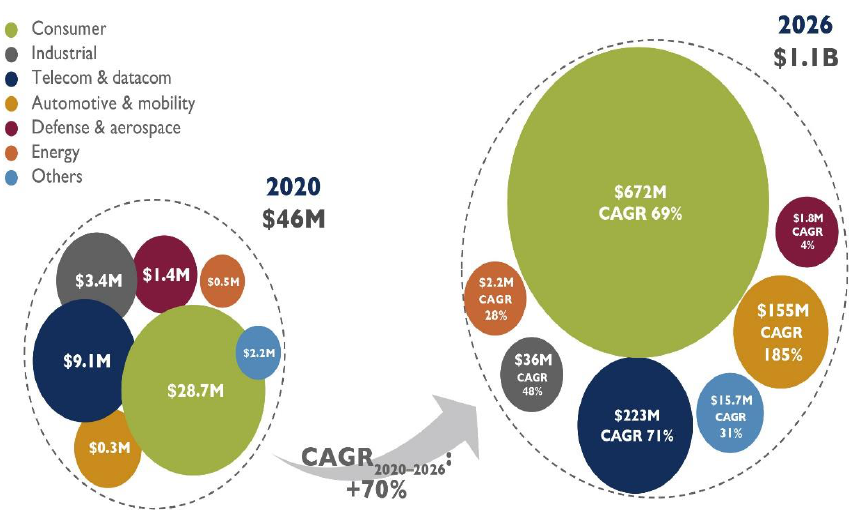
Figure 4. GaN power market forecast split by application prediction by Yole. Reproduced with permission [4]. Copyright 2021, published by Yole Développement.